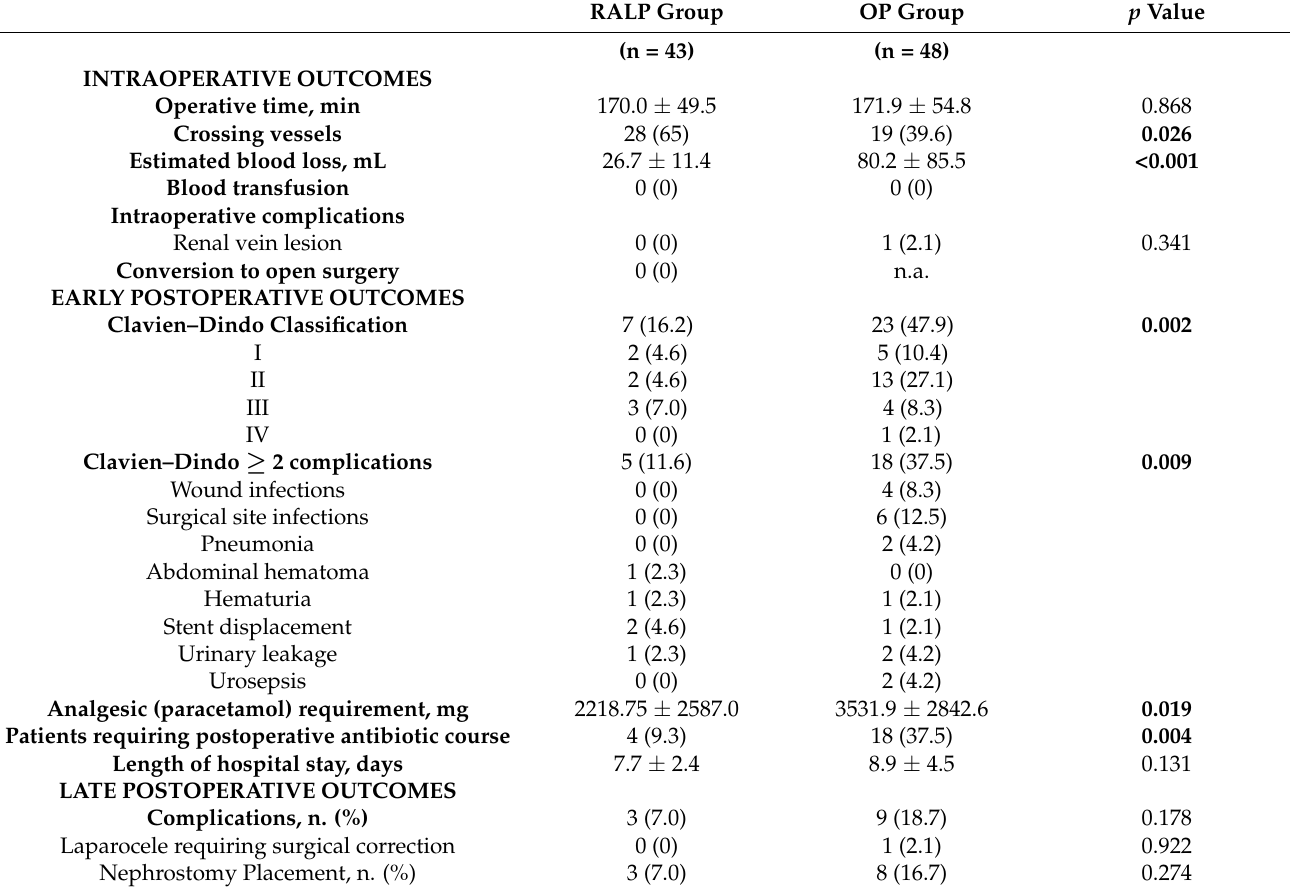
Table 2. Intraoperative and postoperative secondary outcomes. Values are means ± standard deviation or numbers with